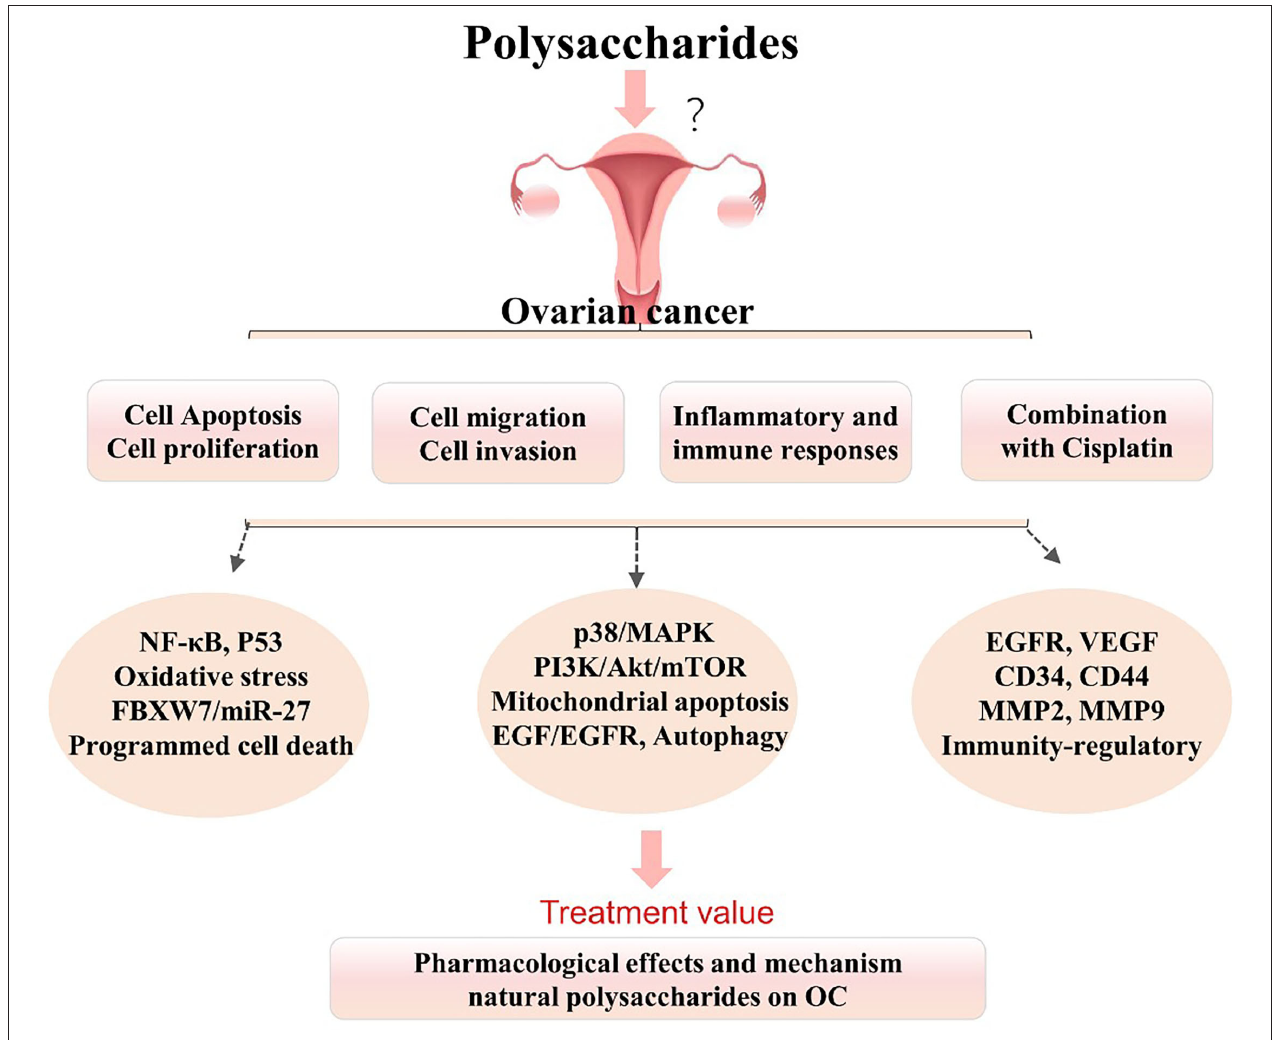
FIGURE 1 | Summarized effects and mechanisms underlying natural polysaccharides in the treatment of ovarian cancer (OC). Polysaccharides play vital roles in the treatment of OC via multiple pathways and molecules, but it remains uncertain whether polysaccharides can be used in the clinical treatment of OC. It is uncertain or not completely verified. BAX, BCL2-associated X protein; EGFR, epidermal growth factor receptor; FBXW7, F-box, and WD-40 domain protein 7; MMP-2/9, matrix metalloproteinase 2/9; MAPK, mitogen-activated protein kinase; NF- κ B, nuclear factor kappa B; OC, ovarian cancer; PI3K, phosphatidylinositol 3-kinase; P53, tumor suppressor gene-53; VEGF, vascular endothelial growth